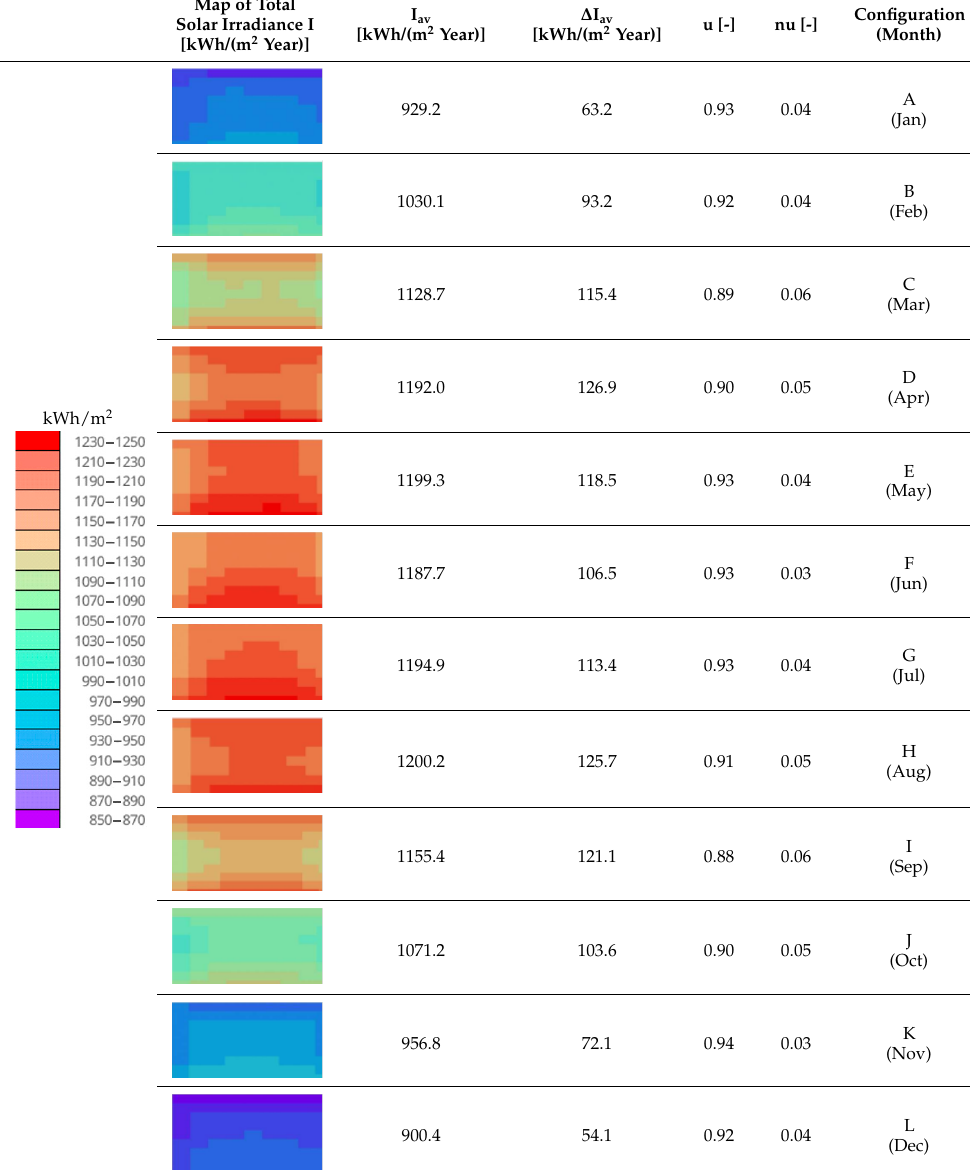
Table 7. Solar irradiance characteristic for cases of PV panels positioned horizontally. Map of Total Solar Irradiance I where I max and I min are the minimum and maximum solar energy densities on solar panel, respectively. For calculation non-uniformity (nu) of solar flux density the formula used by Wang et al. [39]: